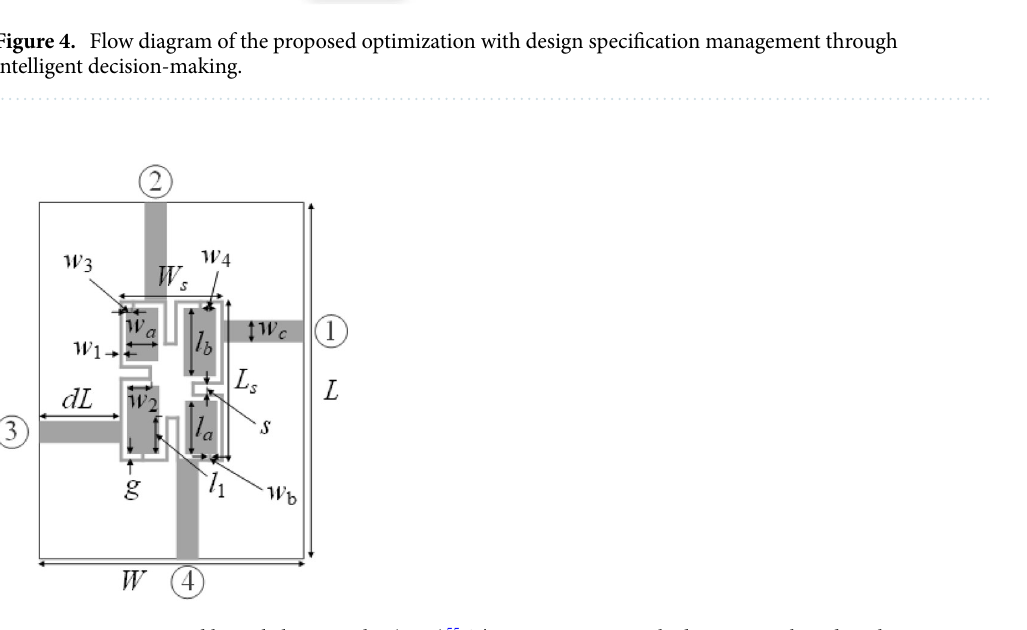
Figure 5. Miniaturized branch-line coupler (BLC) 55 . The circuit ports marked using numbered